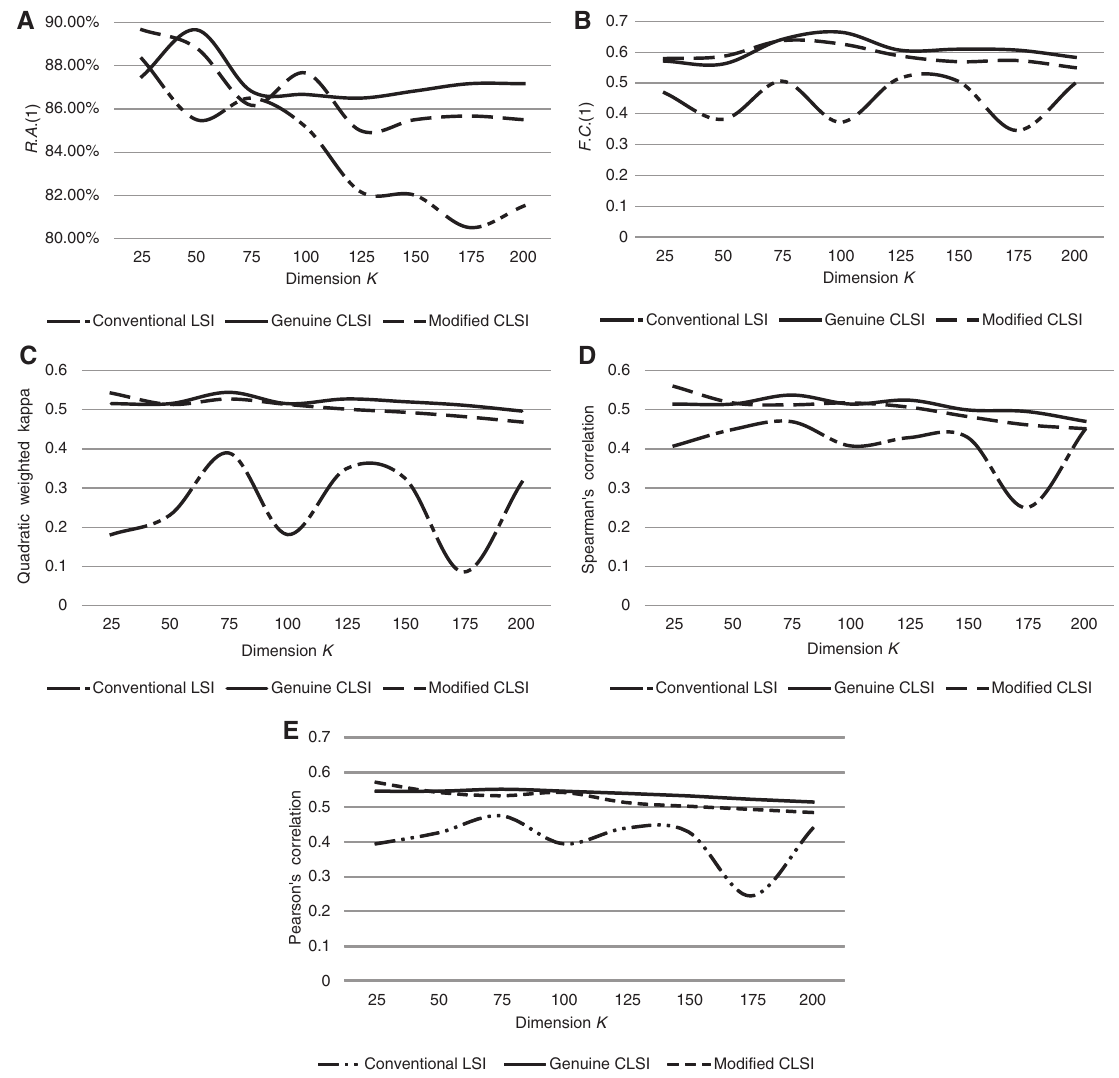
Figure 14: Comparisons of Conventional LSI, Genuine CLSI, and Modified CLSI with Different Dimensions ( K ). (A) Rating Agreement; (B) Fairness Coefficient; (C) Quadratic Weighted Kappa; (D) Spearman’s Correlation; (E) Pearson’s Correlation. Table 7: Scoring Details of Different Methods. Human